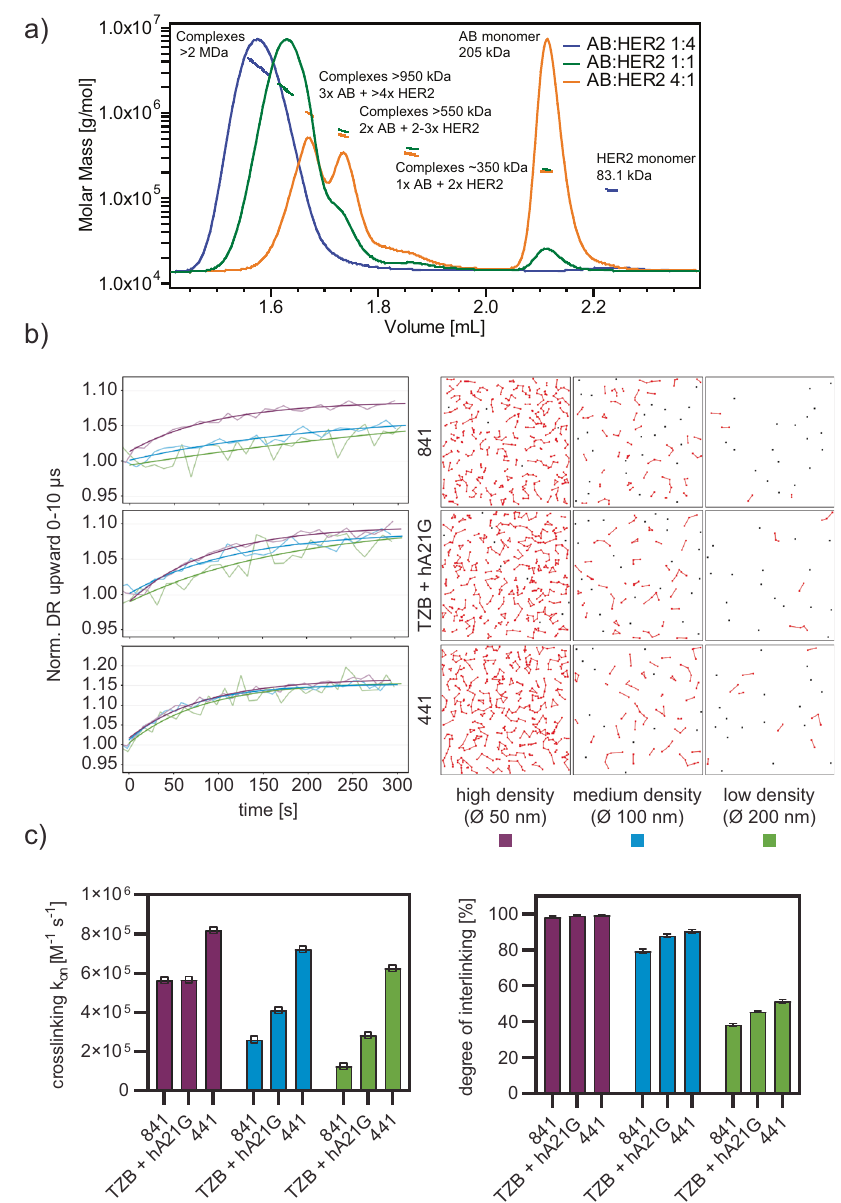
Fig. 4 441 forms complexes with HER2 and interlinks them, facilitates internalization and ultimately degradation of HER2 clusters. a Multi-angle light scattering revealed that 441 formed complexes with HER2 ECD, resulting in higher-order oligomers of up to 2 MDa in size. b Binding studies of tetravalent 441, bivalent 841, and the antibody mixture TZB and hA21G to HER2 (see Supplementary Fig. 4 for detailed kinetic analysis) on DNA nanolevers of different densities (see colors) using the switchSENSE technology. A dependency of the on-rate on ligand density is seen for bivalent constructs (left column panels) but not for the tetravalent construct. Note that the response curves are normalized, re fl ecting the different number of antibodies bound at each surface density. The right-hand panels show a simulated surface, depicting a loss in interlinking of available HER2-DNA conjugates. c The derived association rate constants ( n = 1, each derived from time course) are shown as well as the degree of crosslinking as calculated from the simulations in ( b ) (mean plus error bar SD, n = 100, from ten simulations on ten surfaces). The reduction of binding correlated well with a simulated surface, depicting a loss in interlinking of available HER2-DNA conjugates. Source data are available in the Source Data fi